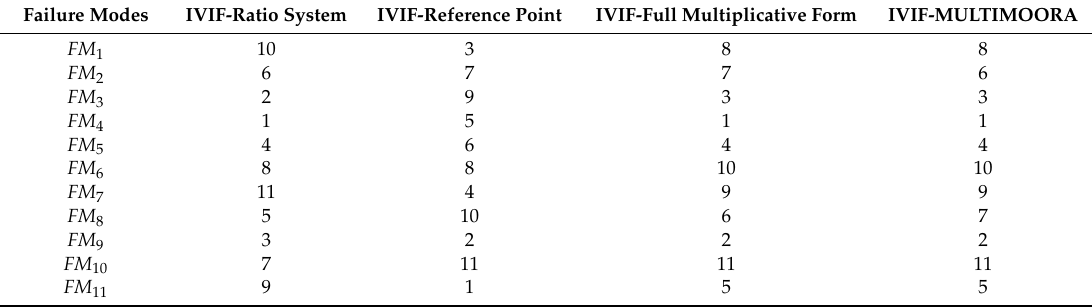
Table 8. The final risk ranking order of failure modes with the IVIF-MULTIMOORA